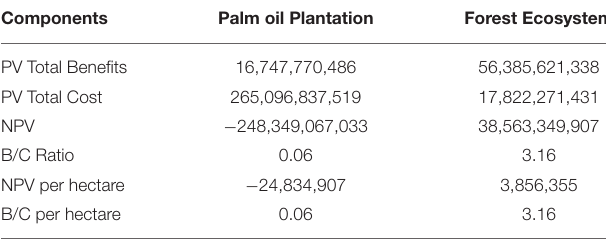
TABLE 8 | Results of the comparison of total cost-benefit feasibility for palm oil plantation and forest ecosystem protection (in thousands IDR). Components Palm oil Plantation Forest